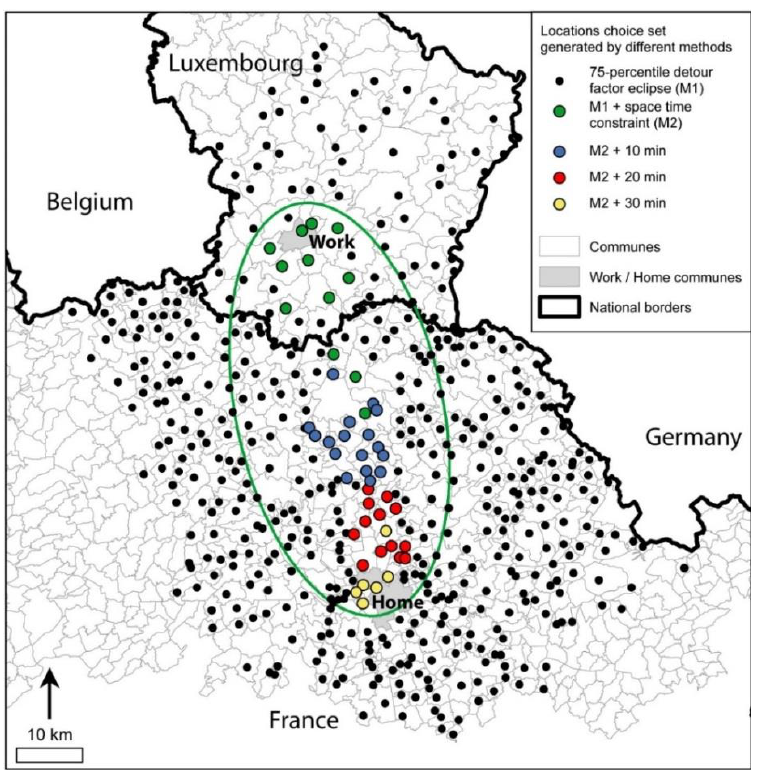
Figure 4. Example of potential area of discretionary activity locations delimited by the ellipse identified by home-work axis and the detour factors in the